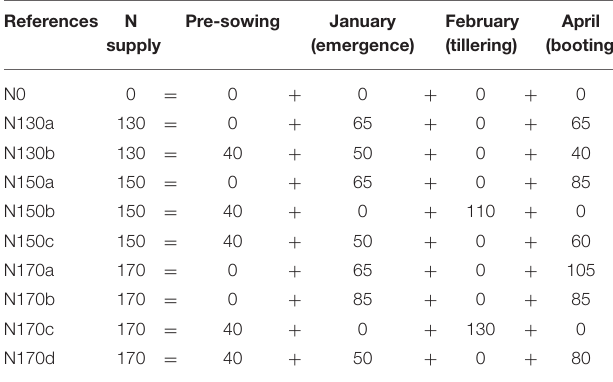
TABLE 1 | N treatments and application dates supplied during the life cycle of barley plants from three genotypes (Meseta, Jallon and